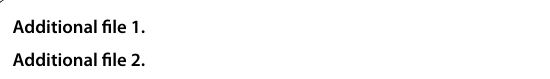
FTB full-thickness rectal